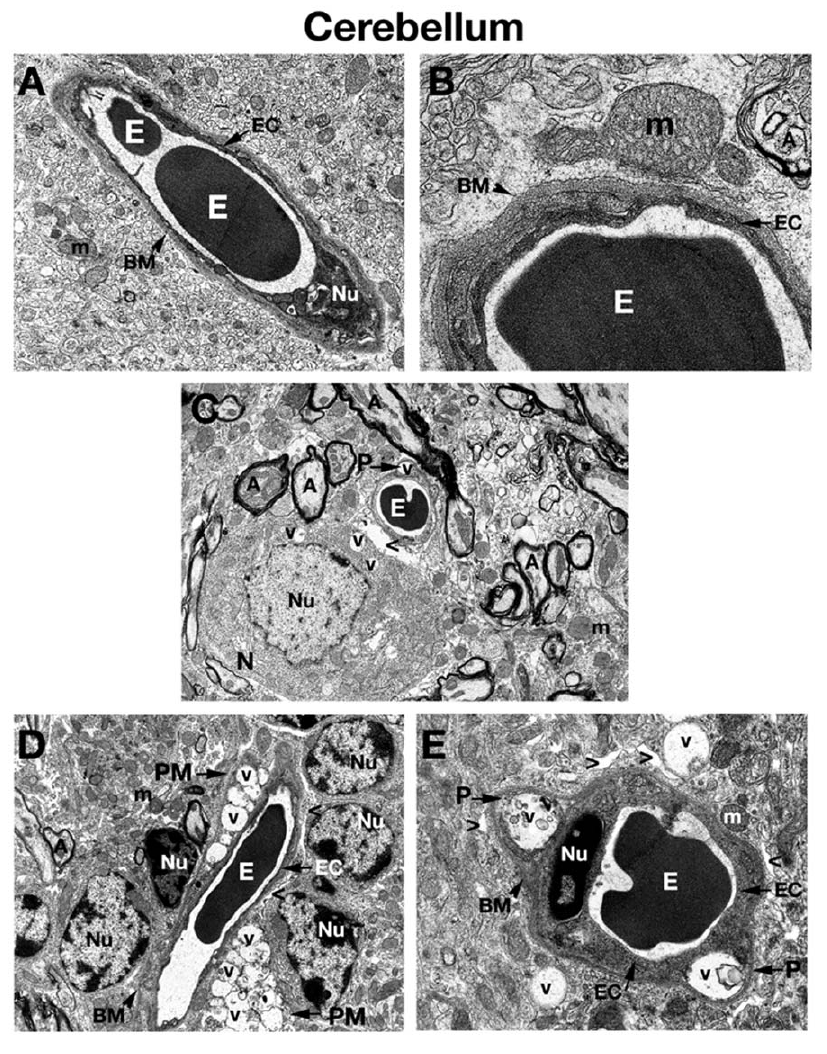
Figure 4. Electron microscope examination of the cerebellum of Naglu mutant mice. ( A ), ( B ) Similar to ultrastructure of microvessels in the cerebral cortex, hippocampus, and striatum, the intact BBB in the cerebellum of a C57 BL/6J control mouse consists of an endothelial cell and a single layer of basement membrane. ( C ) Edematous space around vessel as well as vacuolated pericyte is found in the cerebellum of 3 months old mutant mouse. Vacuoles are also seen in the cytoplasm of neuron located near vessel. ( D ) In 6 months old Naglu mice, two highly vacuolated perivascular macrophages surround a microvessel. Edematous space around vessels is in contact with astrocytic end-feet. ( E ) Pericytes, which contain large vacuoles displacing and destroying cell organelles, can be seen under the capillary basement membrane in mouse at the same stage of disease. Large vacuoles are also visible outside vessel. EC - endothelial cell, BM - basement membrane, E – erythrocyte, m – mitochondrion, A – axon, N – neuron, P – pericyte, PM – perivascular macrophage, Nu – nucleus, V – vacuole, . - extracellular edematous space. Magnifications: ( A ) 7,100x; ( C ), ( D ): 4,400x; ( B ): 28,000x; ( E ): 11,000x.